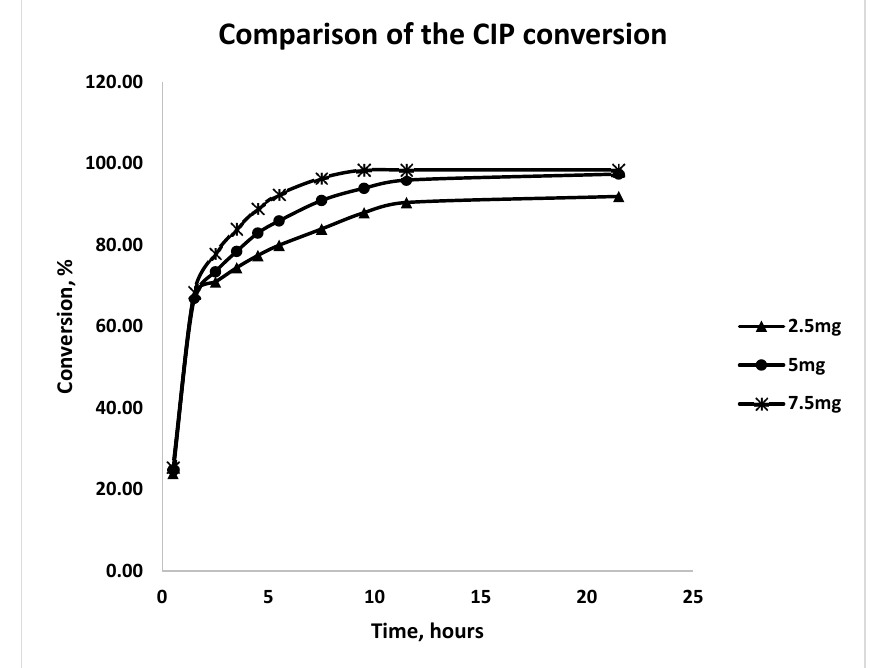
Figure 9. CIP conversion with different loading of CuFe 2 O 4 - 70% /rGO/HNT.